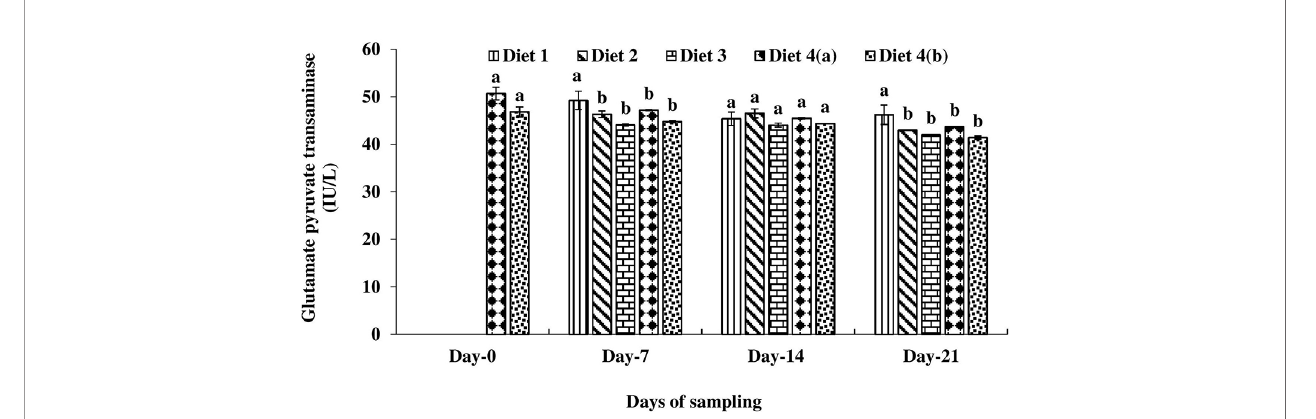
FIGURE 3 | Glutamate pyruvate transaminase level found in four different diets fed UV-B exposed and unexposed Catla catla . Bars with different superscripts (a-b) are signi fi cantly different (n = 3).